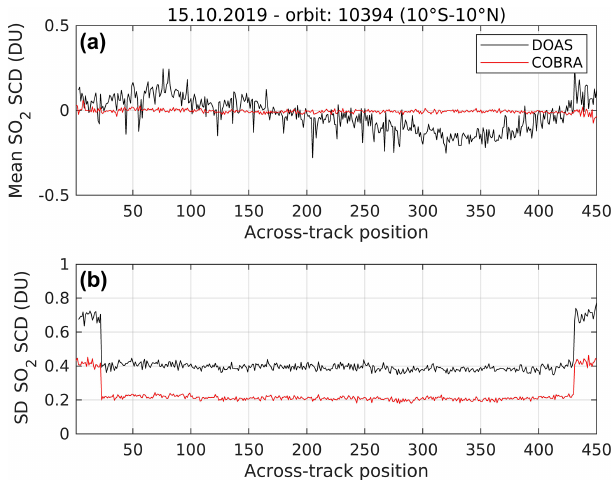
Figure 1. (a) Mean SO 2 slant columns from (black) DOAS (back- ground corrected) and (red) COBRA for one orbit (10394 on 15 Oc- tober 2019) over the equatorial Pacific region (10 ◦ S–10 ◦ N), as a function of the across-track position of TROPOMI, (b) same as (a) for the SO 2 SCD standard